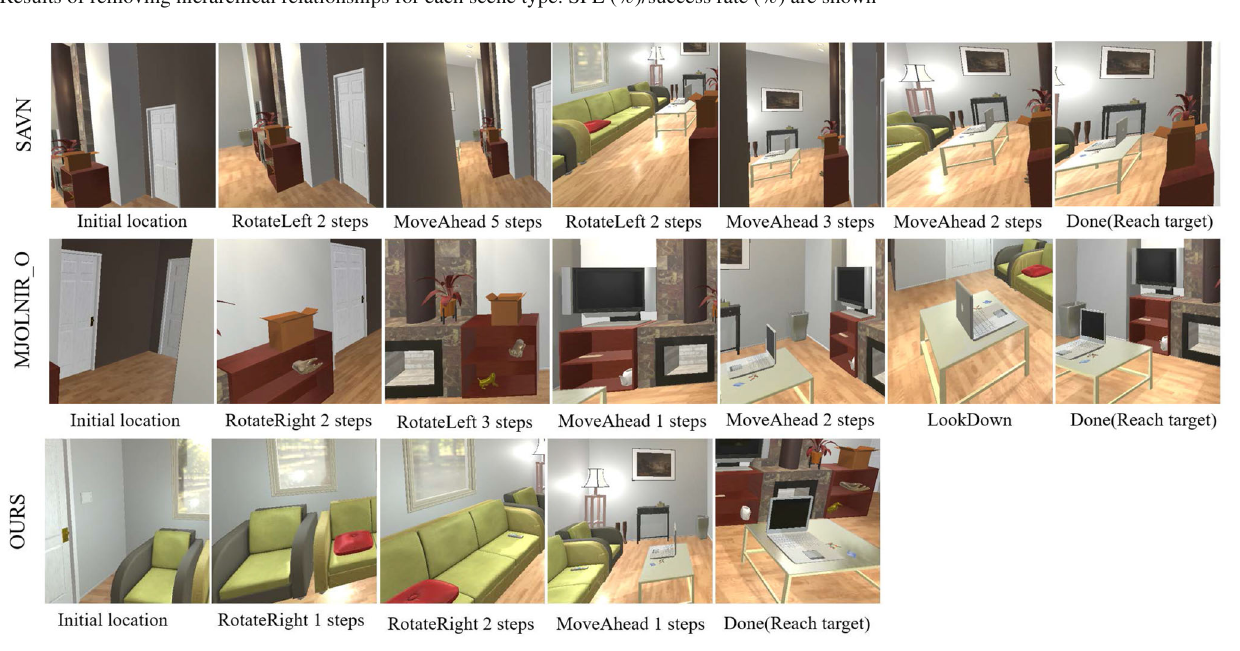
Fig. 4 Qualitative example. Qualitative comparison of two sample trajectories between our model and the baseline. The target object (i.e., Laptop) in the living room. In comparison, SAVN and MJOLNIR_O takes more steps to find the goal